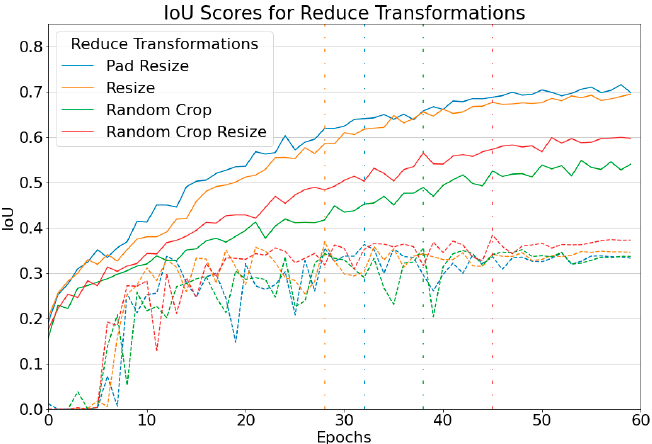
Figure 13. IoU scores comparing the four Reduce Transformations. The solid lines show training IoU scores, while the dashed lines show validation IoU scores. The loosely dotted vertical lines show where the best epoch (highest Val IoU) for a given method. Adding more variations to the input delays the overfitting and is shown by a later best epoch. Table 2. Results of Ablation study. All scores are in percentage units. For loss, the lower is better. For IoU, the higher the better. Scores are color-coded in comparison to Pad Resize, where green color projects positive gain while red projects negative gain.